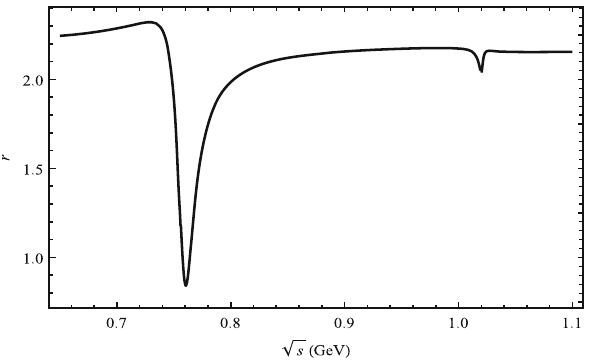
√ s corresponding to central param- Fig. 4 Plot of r as a function of eter values of CKM matrix elements for the decay channel of ¯ B 0 s → π + π − π 0